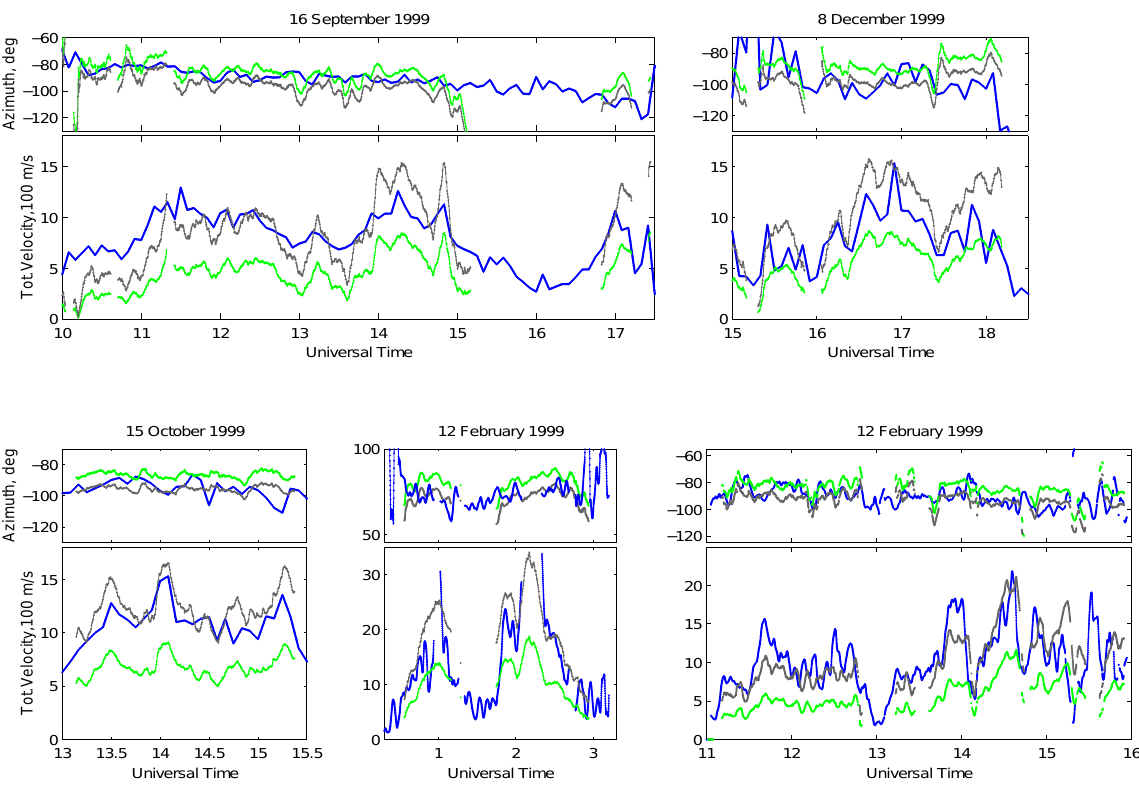
Fig. 7. Four evening and one morning case of the EISCAT electron flow azimuth (narrow panels) and magnitude (wider panels), blue lines, together with the OOFA estimates of the electron flow (grey lines) based on the STARE MP parameters (green